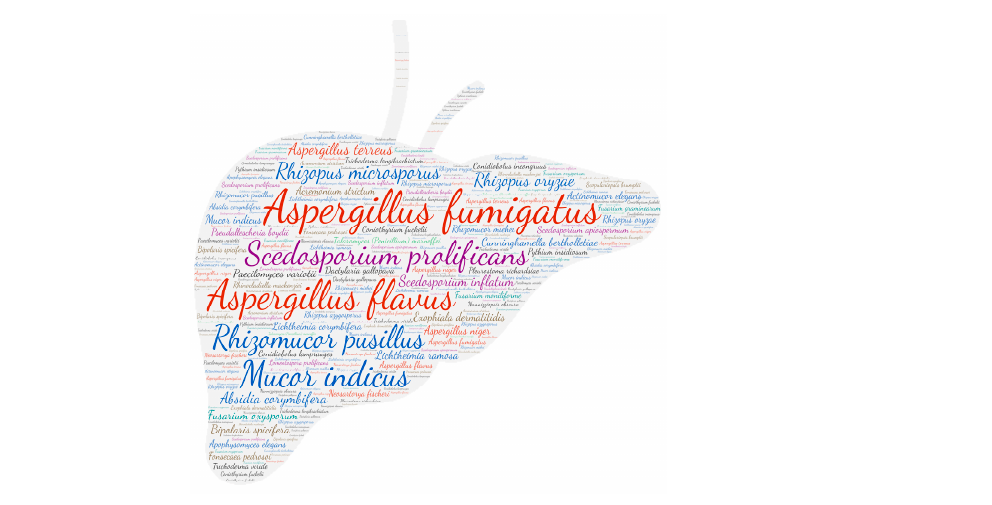
Figure 12. Wordcloud represents the species name isolated in the osteo-articular system. The size of the name of each species is proportional to the number of times it occurs in the repertoire.